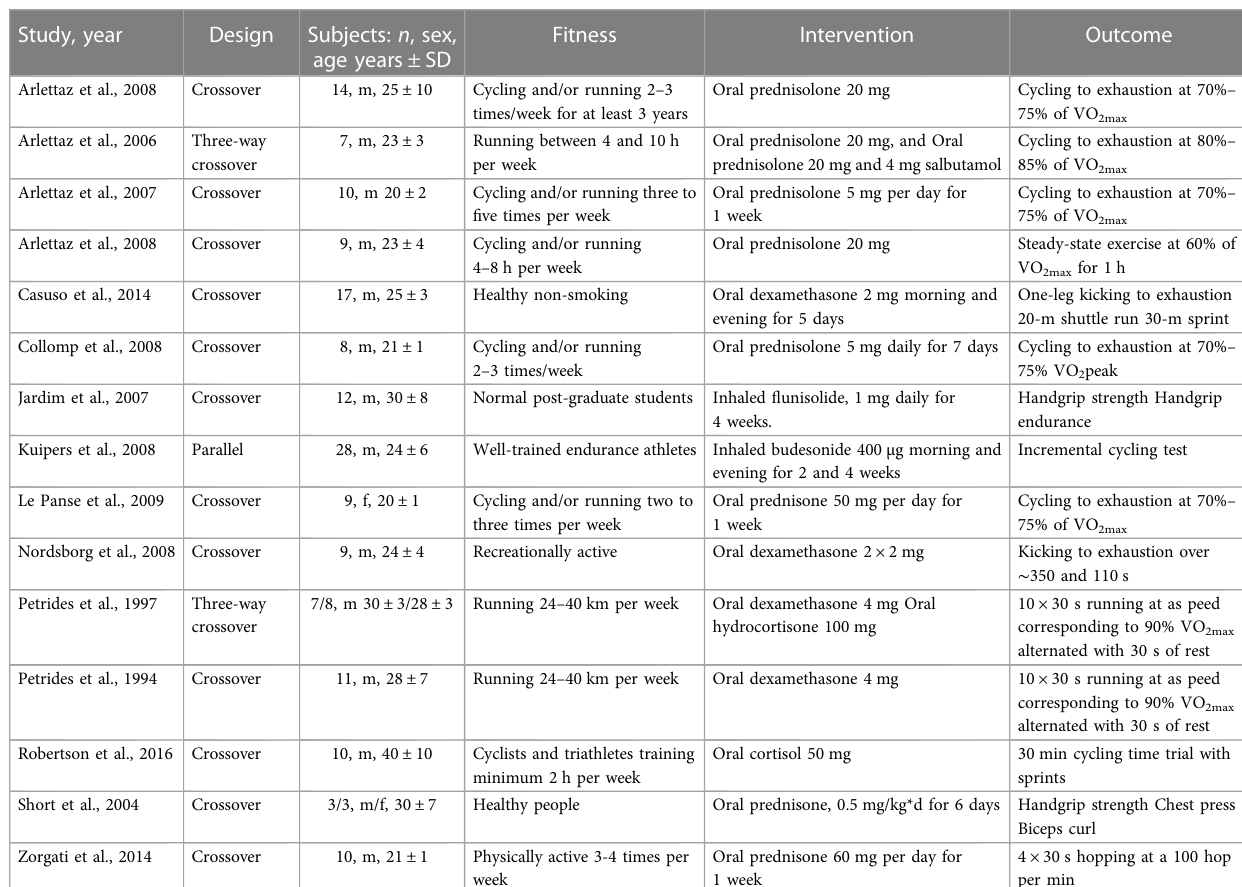
TABLE 1 Characteristics of the included